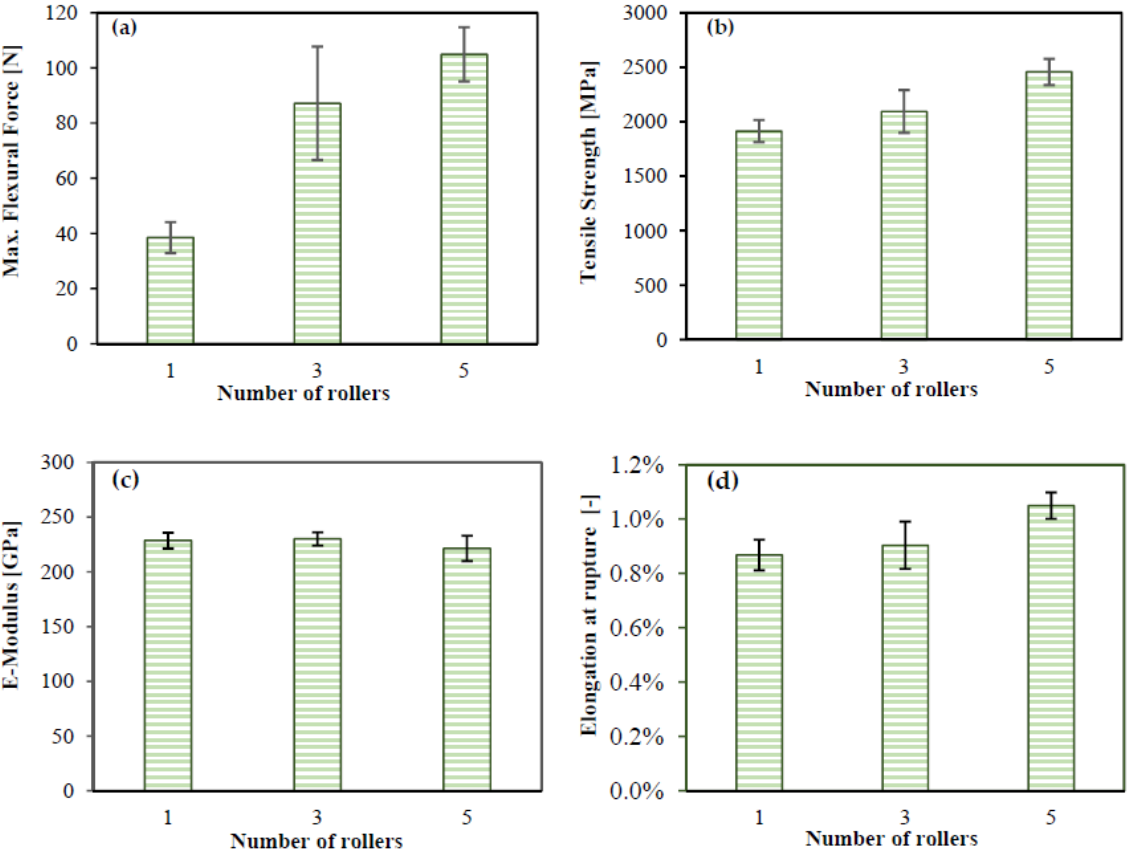
Figure 6. ( a ) Maximum flexural forces; ( b ) uniaxial tensile strengths; ( c ) E-modulus; and ( d ) elongation-to-rupture of MCFs depending on the number of impregnation rollers.